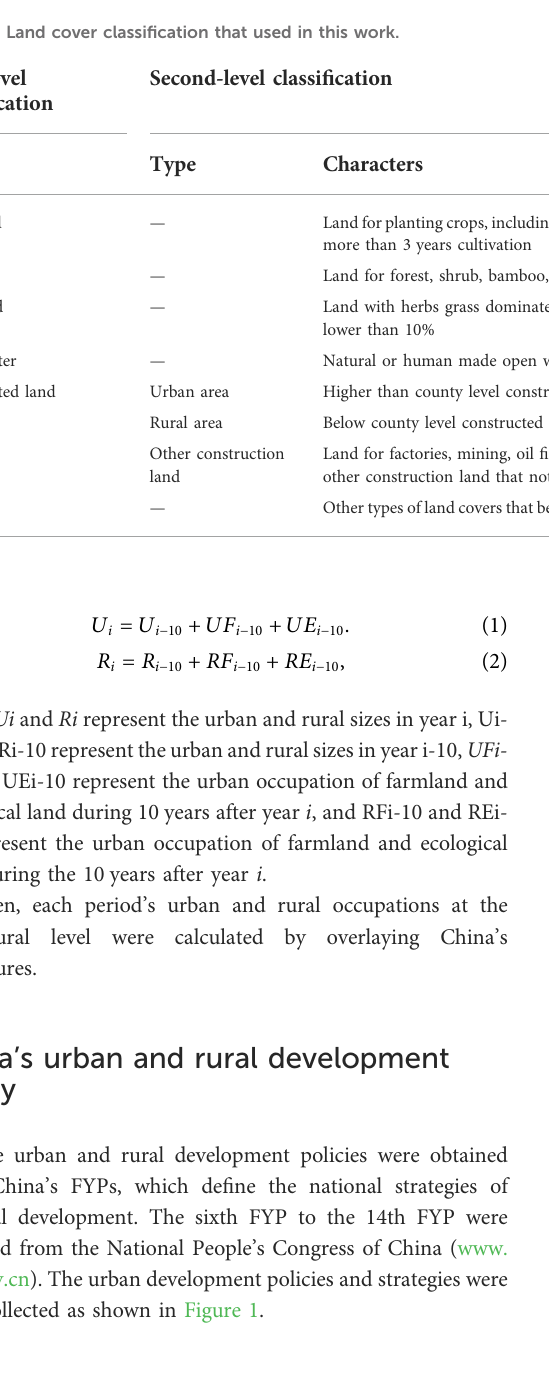
TABLE 1 Land cover classi fi cation that used in this